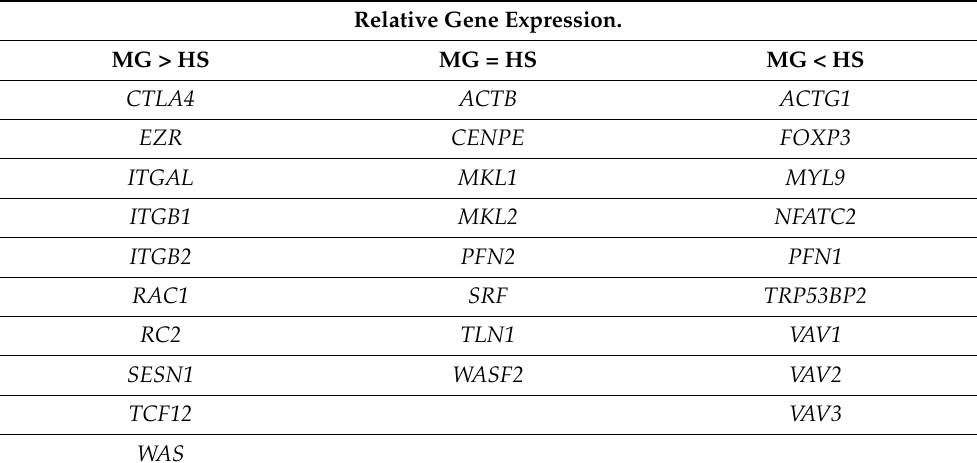
Table A4. Three groups of actin cytoskeleton network and related genes according to their relative differential gene expression levels in response of human T cells to simulated microgravity (MG) and under hydrodynamic stress (HS) confirmed by using